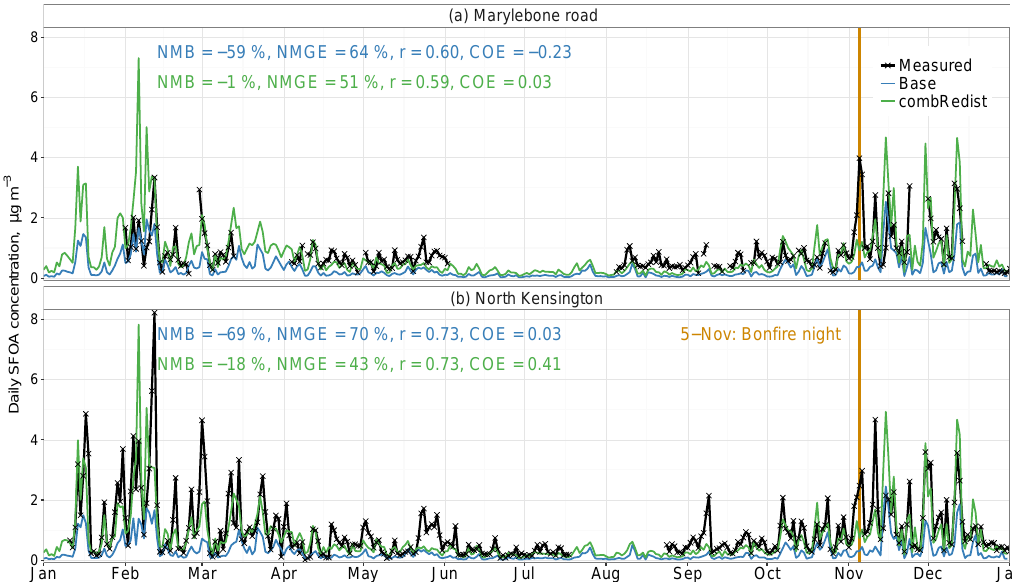
Figure 6. Time series of measured and modelled ( Base and combRedist experiments) daily average SFOA concentrations at the (a) Maryle- bone Road, and (b) North Kensington measurement sites, year 2012. The vertical line marks the date of “bonfire night”, 5 November. The annual average measured SFOA concentrations at these sites were 0.9µgm − 3 at Marylebone Road, and 1.0µgm − 3 at North